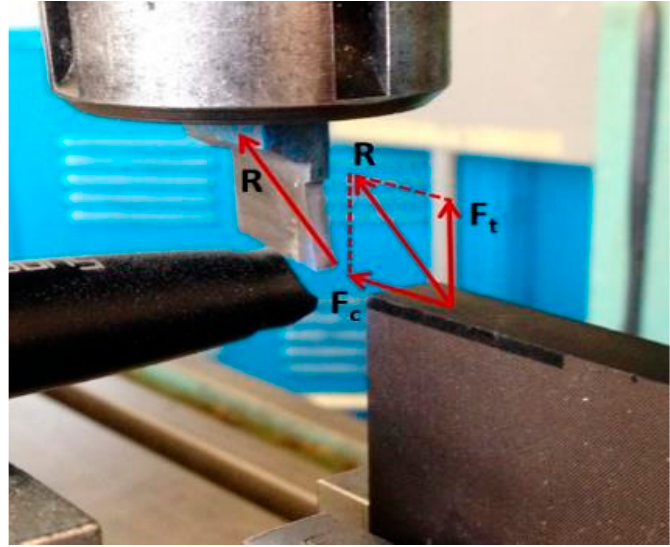
Figure 3. The analysis of resultant machining force.